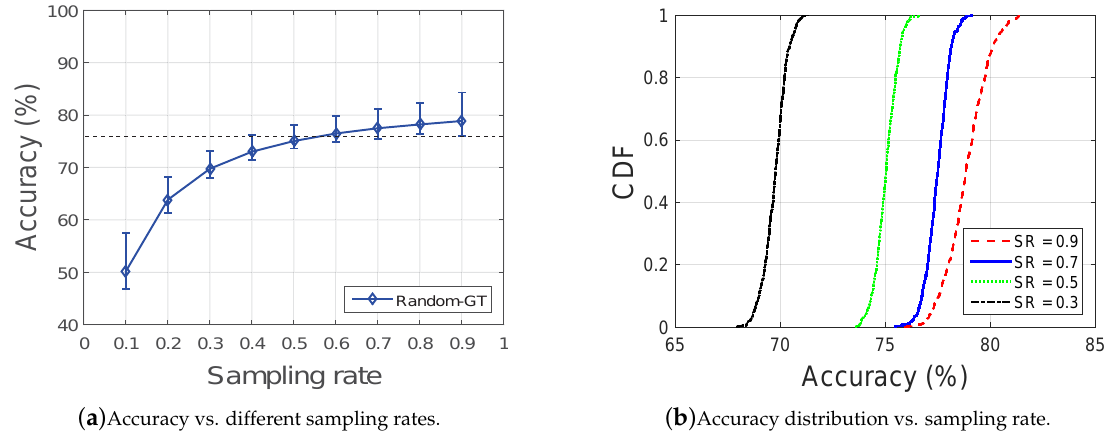
Figure 6. Errors introduced without differentiating the nodes (George Town data).